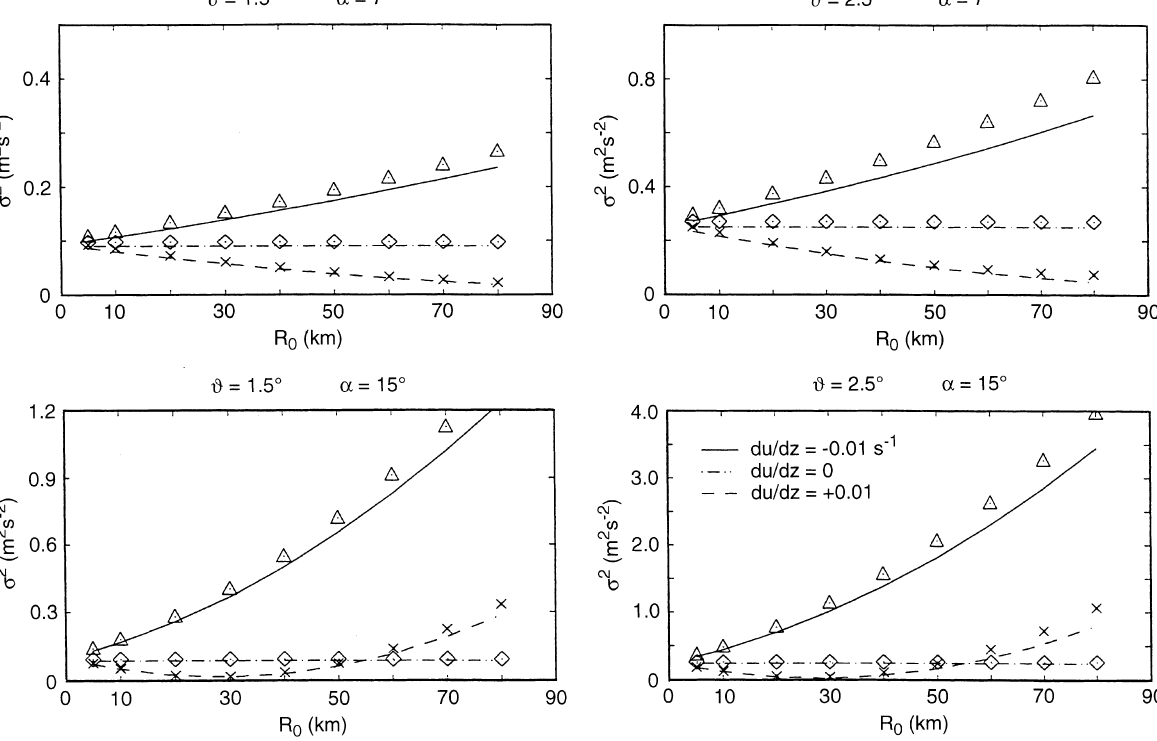
Fig. 4. As in Fig. 3, except for solutions as a function of range for typical vertical wind shear values. Note that the ordinate scales di(cid:128)er among